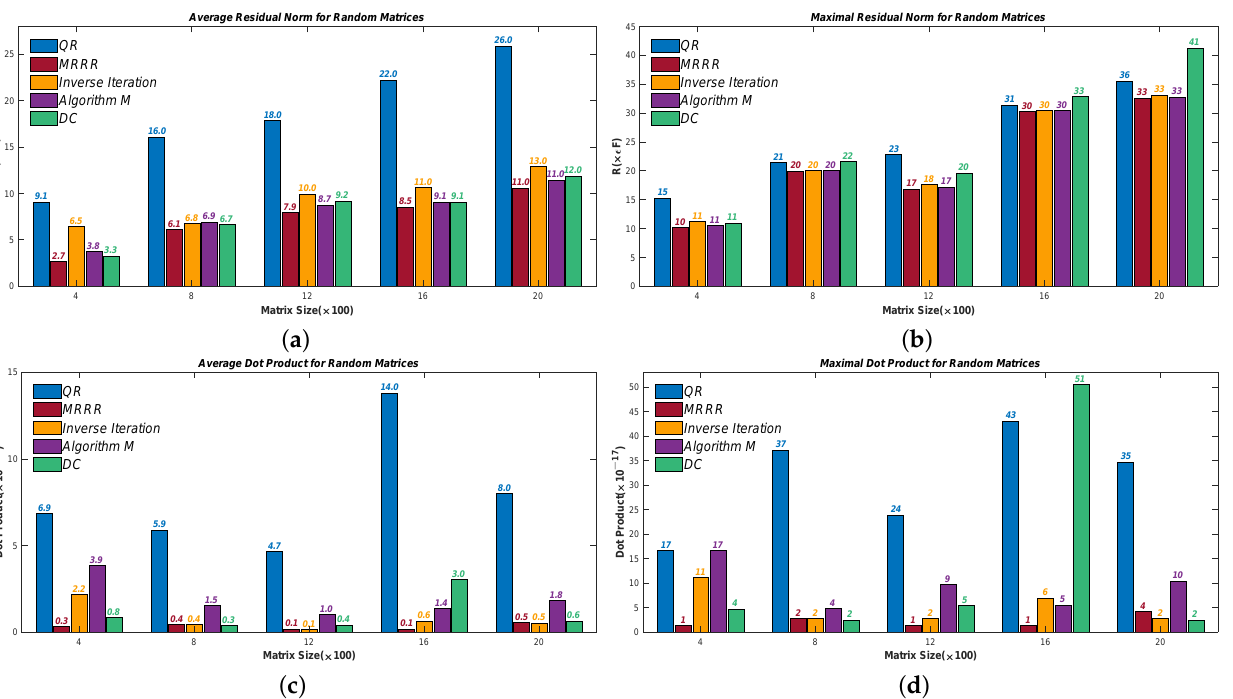
Figure 9. The accuracy results of Random Matrices: ( a ) the average residual norm; ( b ) the maximal residual norm; ( c ) the average dot product; ( d ) the maximal dot